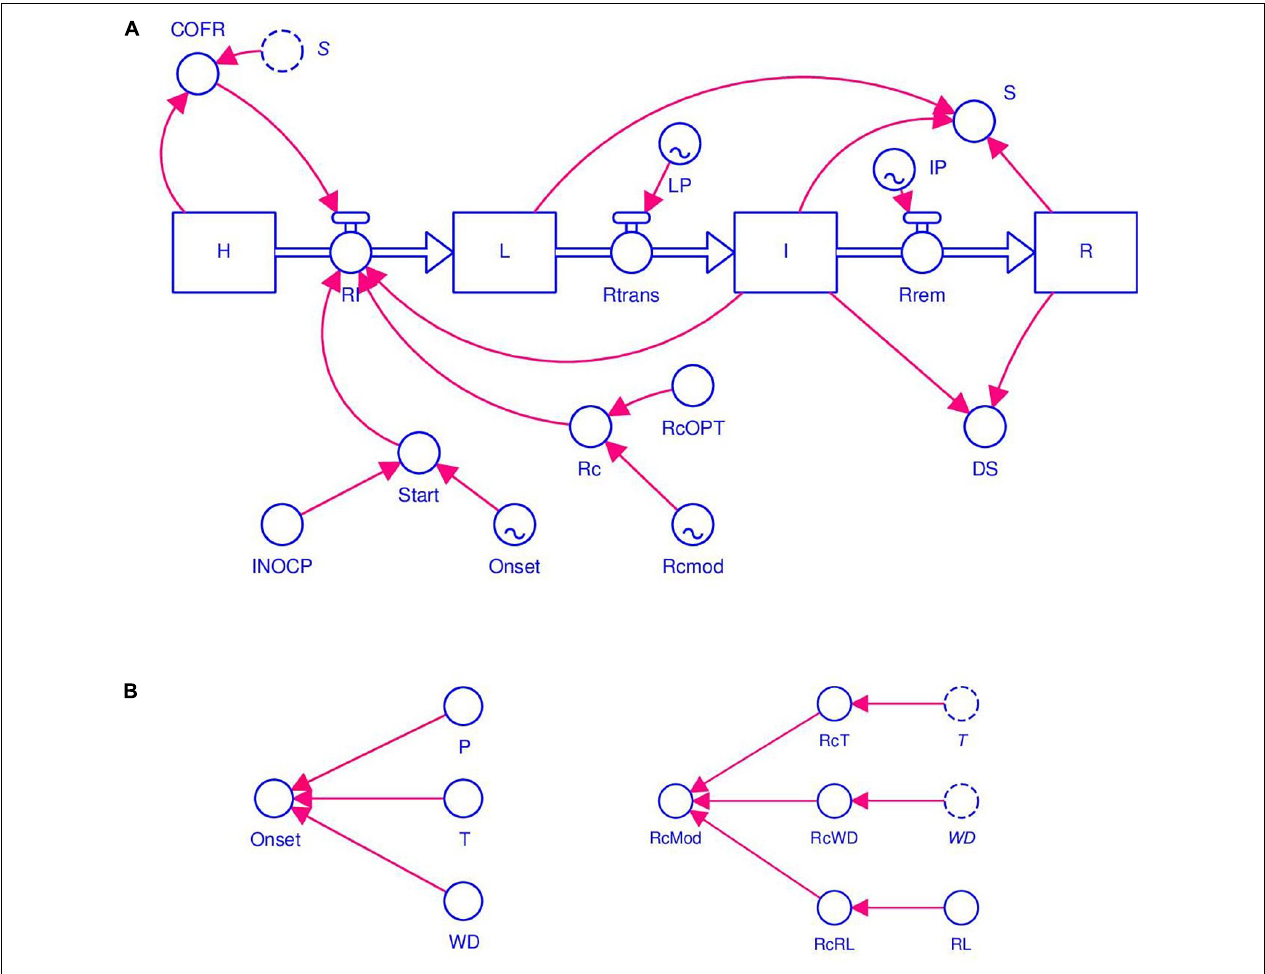
FIGURE 1 | Flow chart of stem rust of wheat. The diagram uses the symbols developed by Forrester (1961). Symbols for state variables, rates, and parameters are listed in Table 1 . (A) Core structure of the model based on Zadoks (1971), with sites evolving from healthy (HS), to latent (L), to infectious (I), and finally to removed (R). The initiation of an epidemic depends on primary infections (INOCP, Onset). The progress of the epidemic depends on secondary infections (RI, Rc, and I). The model’s core works with a daily time step. (B) Conditions for primary infections and modifiers of secondary infections (RcWD, RcT, and RcLR), which are calculated with an hourly time